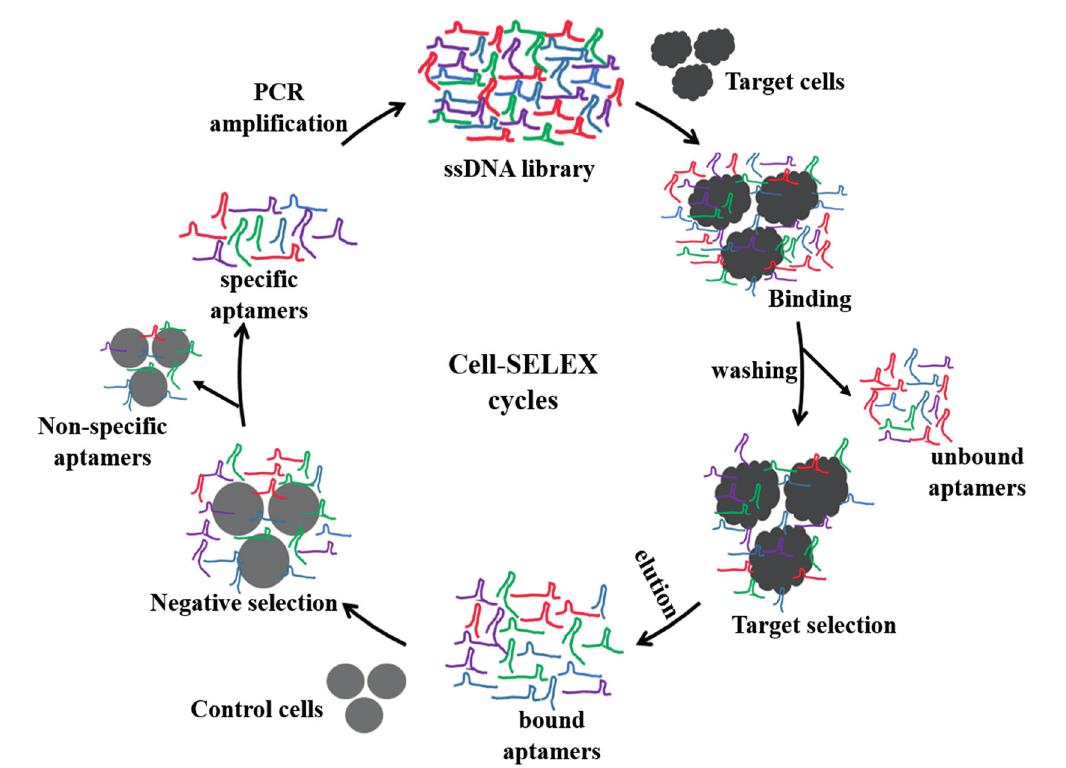
Figure 1. Schematic representation of